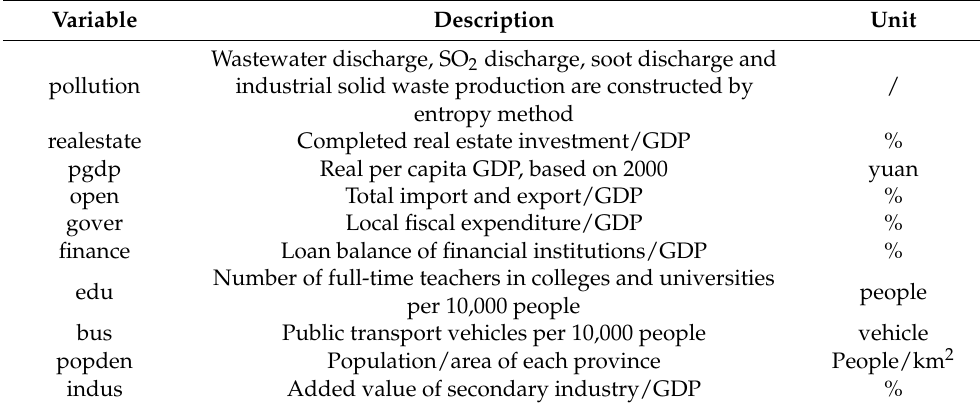
Table 2. Variable